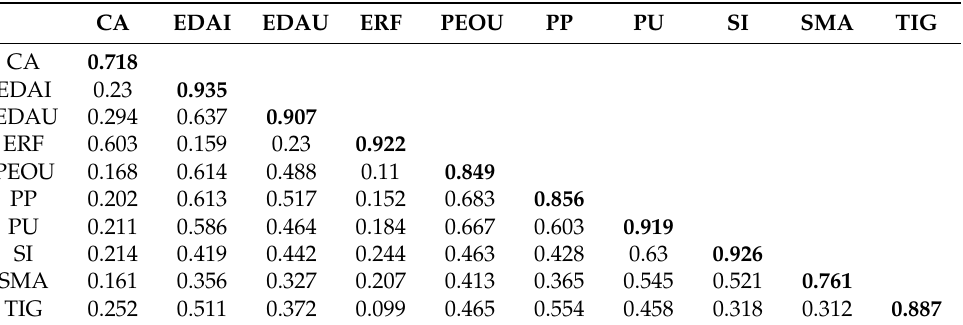
Table 3. Discriminant validity of the constructs.